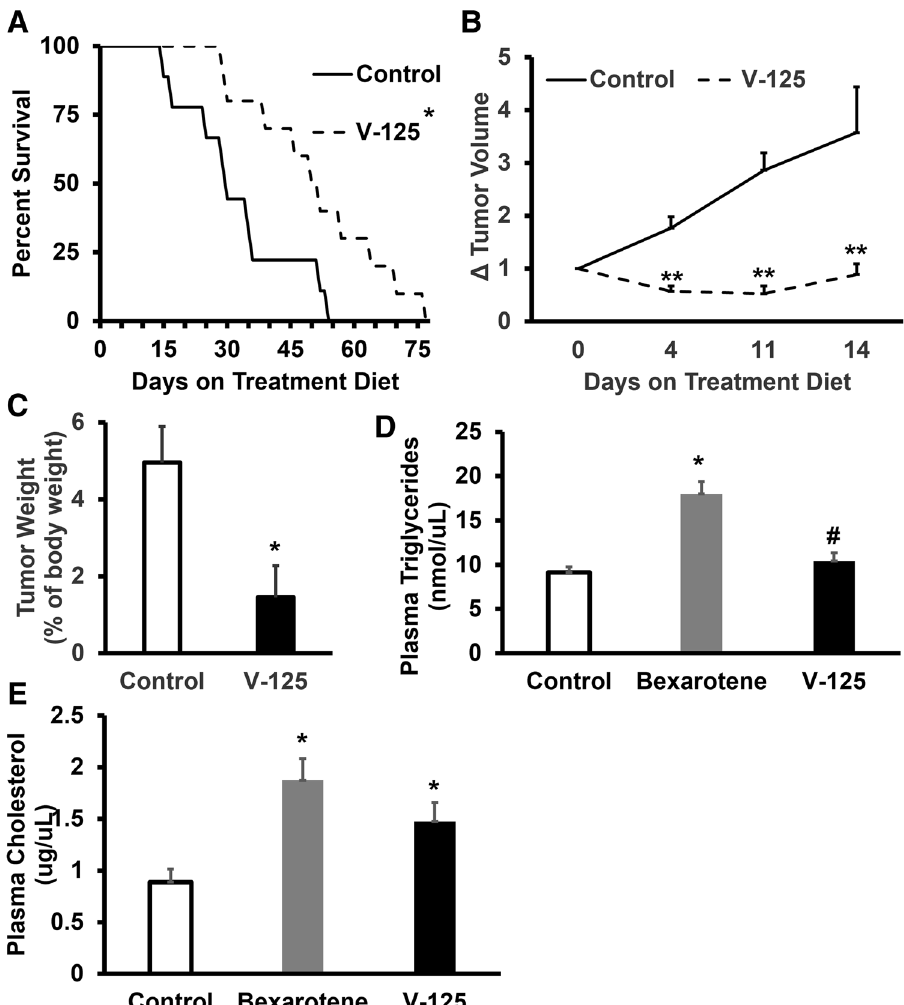
Figure 4. V-125 extends overall survival in MMTV-Neu mice. Female MMTV-Neu mice with established mammary tumors 5 mm in diameter were fed control diet or V-125 (100 mg/kg in diet) until tumors reached endpoint as defined by IACUC guidelines ( A,B ) or for 10 days ( C – E ). ( A ) Overall survival is plotted for control and V-125-treated groups (*P < 0.0172 vs. control via log rank test; N = 9–10 mice per group). ( B ) Tumor volume over the first 14 days of treatment with V-125 was calculated and normalized to initial tumor volume (**P < 0.01 vs. control). C. Tumor weight at the end of 10 days of treatment is presented as a percent of body weight (*P < 0.05 vs. control; N = 6–8 mice per group). Plasma triglycerides ( D ) and cholesterol ( E ) levels in mice treated with control or rexinoids (100 mg/kg diet) for 10 days were quantified using commercial kits (*P < 0.01 vs. control; # P < 0.01 vs. bexarotene; n = 6–11 mice/group). All error bars represent the standard